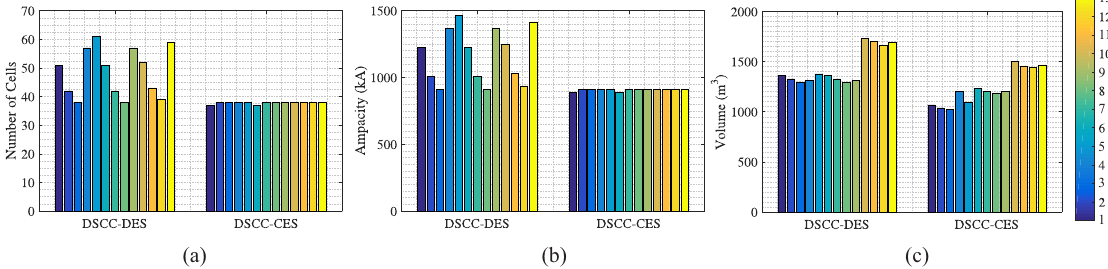
Figure 9. Comparison of DSCC-DES and DSCC-CES topologies for different LIB part numbers: ( a ) Number of cells. ( b ) Converter ampacity. ( c ) Batteries’